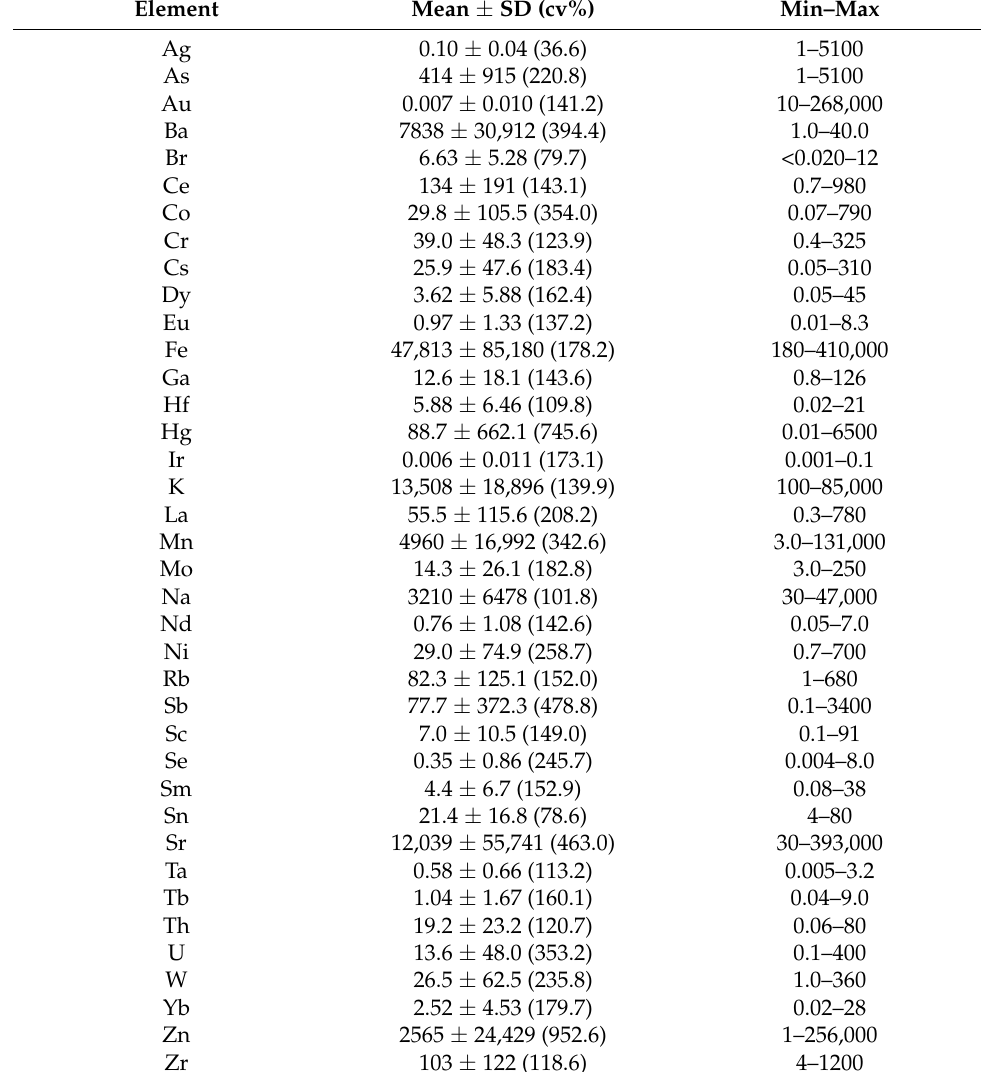
Table 6. Mean values ( µ g g − 1 ± standard deviation (SD)), variability (as coefficient of variation, cv%, data reported in brackets) and min–max values for each element determined in overall the samples